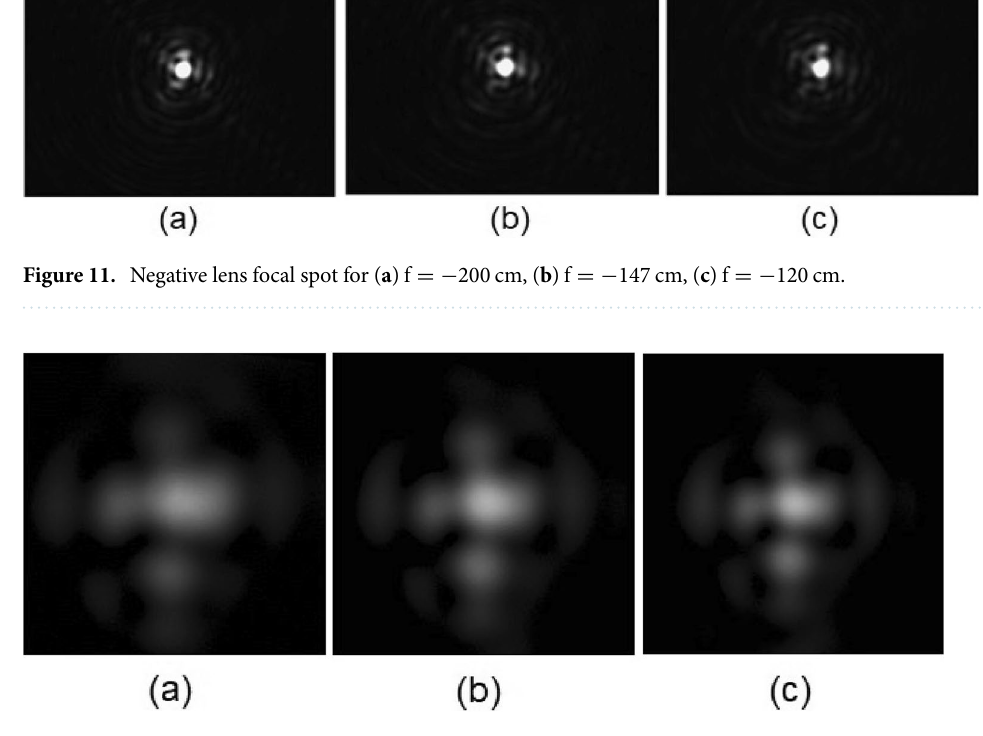
Figure 12. Different PSFs for ( a ) V 1 = 1.75 V RMS and V 2 = 4.5 V RMS . ( b ) V 1 = 1.80 V RMS and V 2 = 0.6 V RMS ( c ) V 1 = 1.85 V RMS and V 2 = 0.6 V RMS .